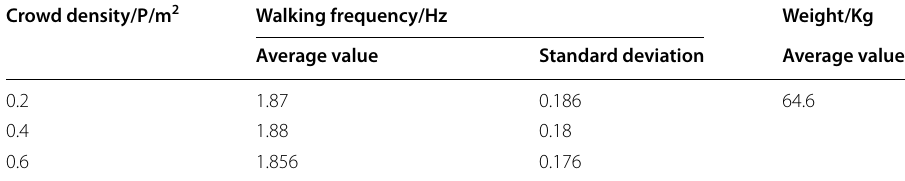
Table 1 Step frequency and weight corresponding to crowd density Crowd density/P/m 2